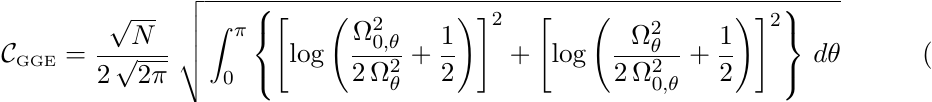
/N from (5.16) GGE